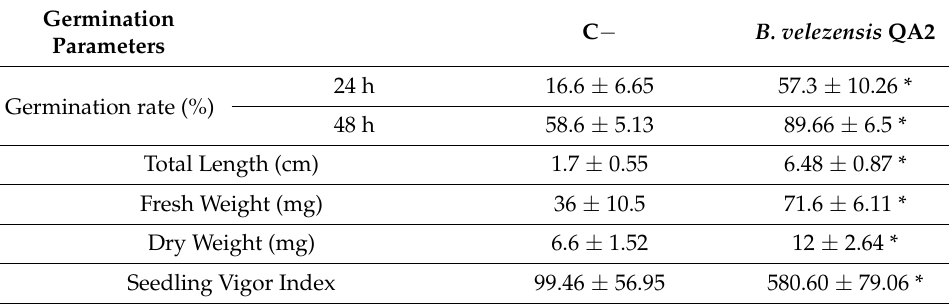
Table 3. Effect of B. velezensis QA2 strain on quinoa seed germination in